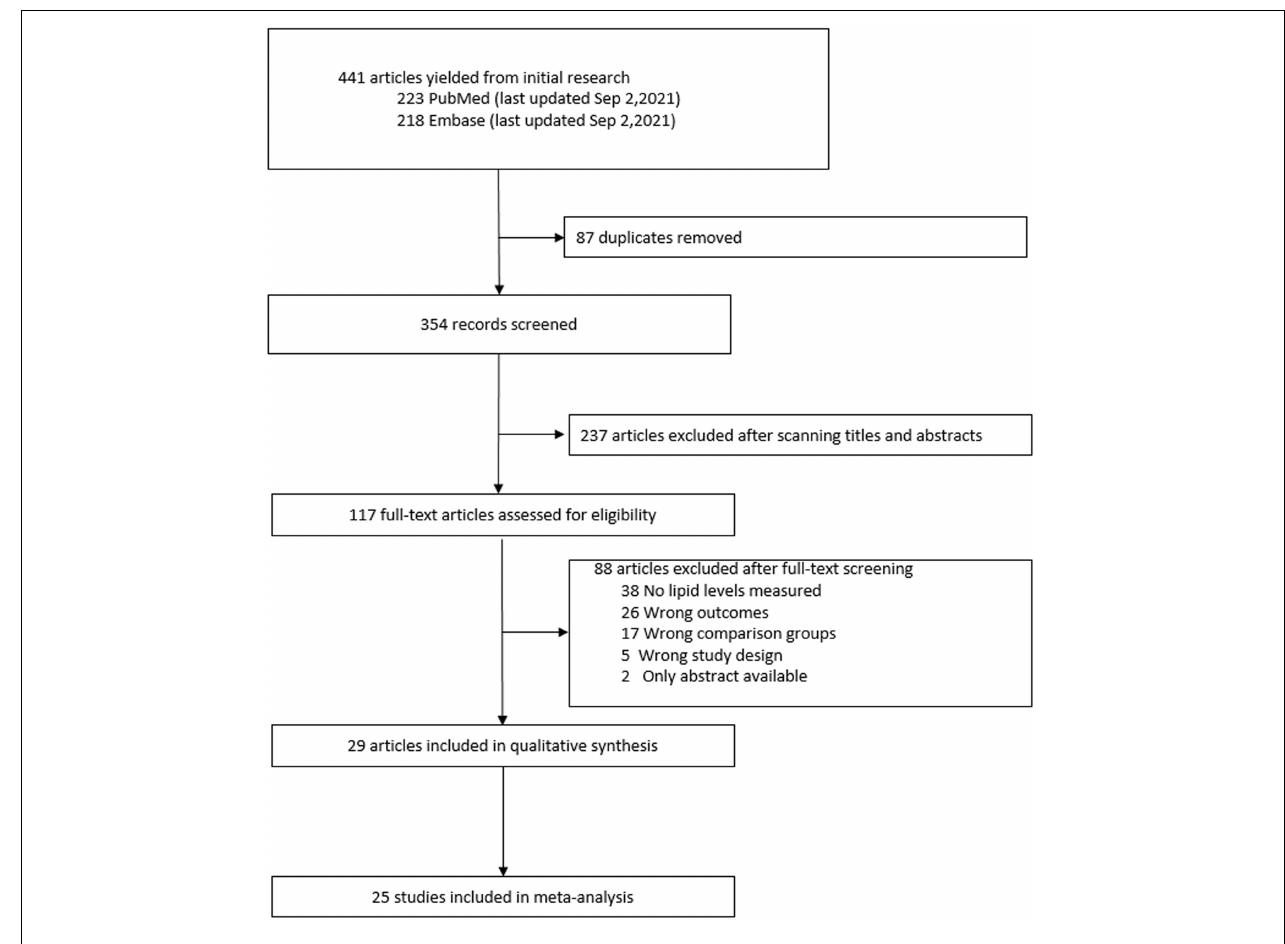
FIGURE 1 | Study selection for the systematic